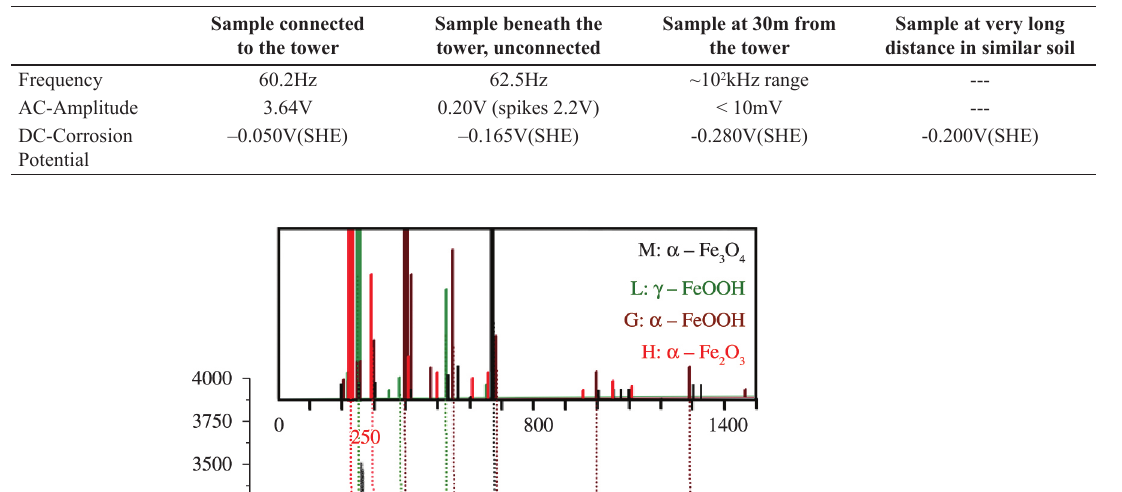
Table 1. In-situ AC/DC measurements in the soil.